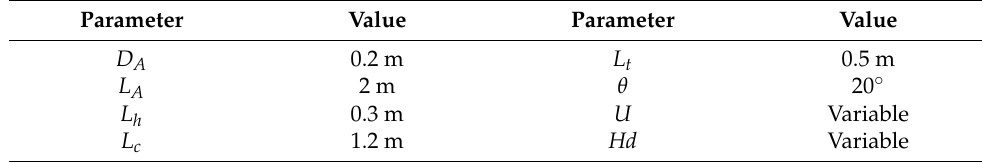
Figure 1. ( a ) Lateral view of self-propelled UUV; ( b ) front view of self-propelled UUV. Table 1. Main parameters of UUV hull.